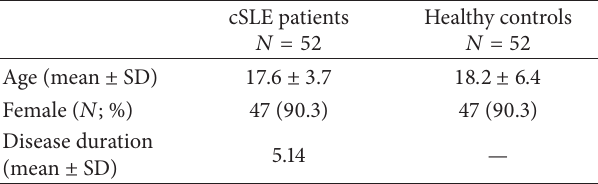
Table 1: Demographics data from cSLE and controls.